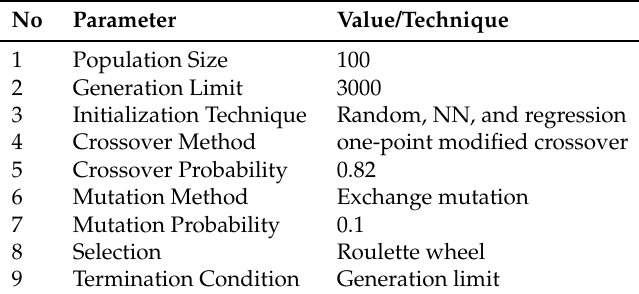
Table 1. GA configuration parameters for experiments.